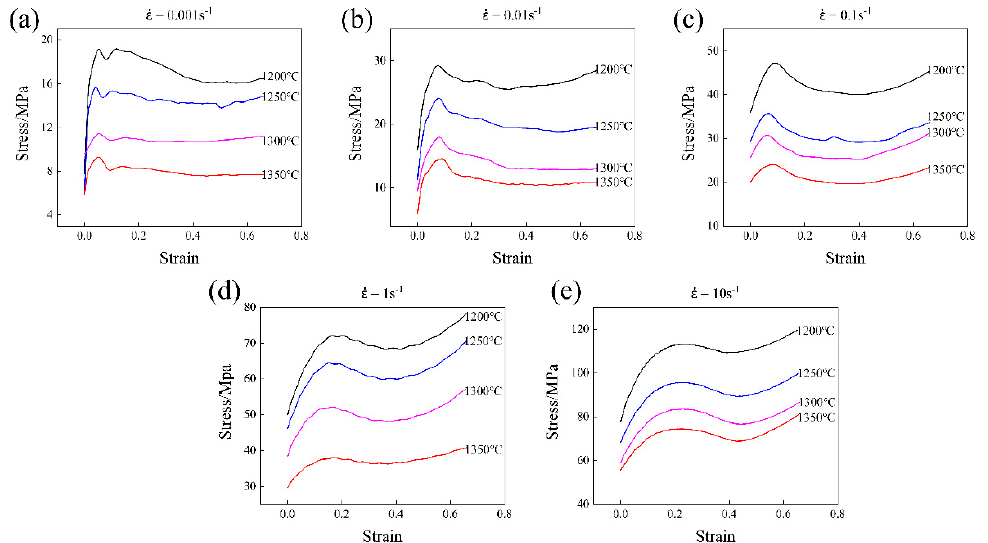
Figure 2. True − stress/true − strain curve of 42CrMo steel after friction correction under different deformation conditions: ( a ) 0.001 s − 1 ; ( b ) 0.01 s − 1 ; ( c ) 0.1 s − 1 ; ( d ) 1 s − 1 ; and ( e ) 10 s − 1 .